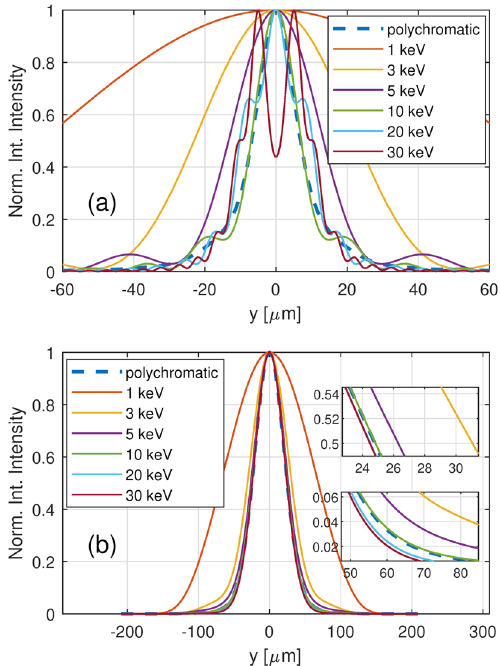
FIG. 6. Simulated normalized intensity (vertical profiles) from the x-ray pinhole-camera diagnostic beamline for polychromatic x-rays (dashed lines) and monochromatic x-rays (solid lines) for (a) the PSF and (b) the convolution of the PSF with the particle density distribution in the electron